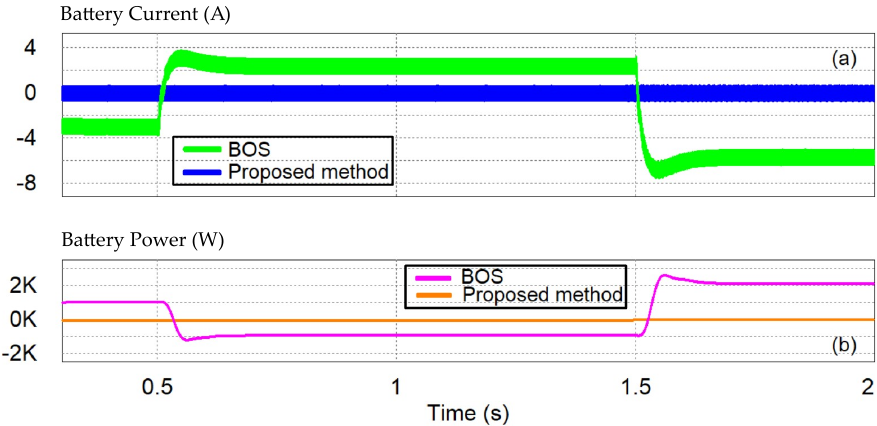
Figure 12. ( a ) The ba tt ery current; ( b ) the ba tt ery power—Case 1.